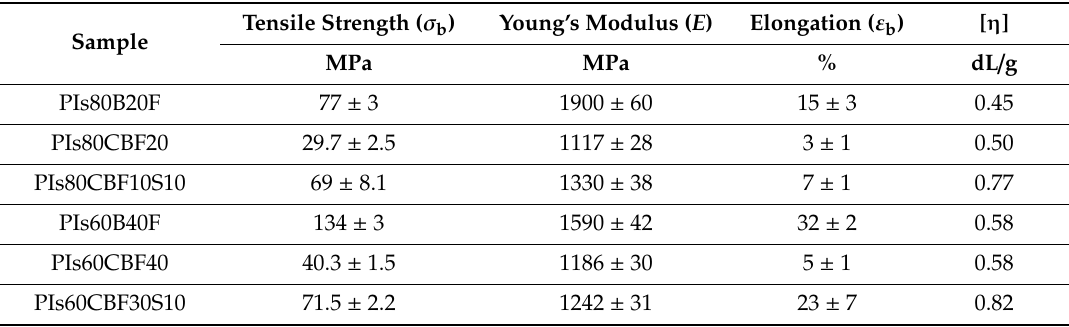
Table 2. Influence of the isosorbide carbonate and butylene succinate units in the tensile properties of PBF- co -PBS- co -PIsC copolymers